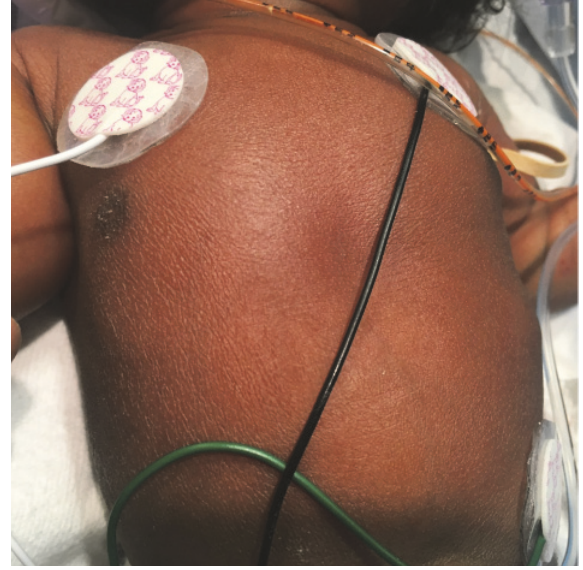
Figure 2: Photo showed wide-spaced